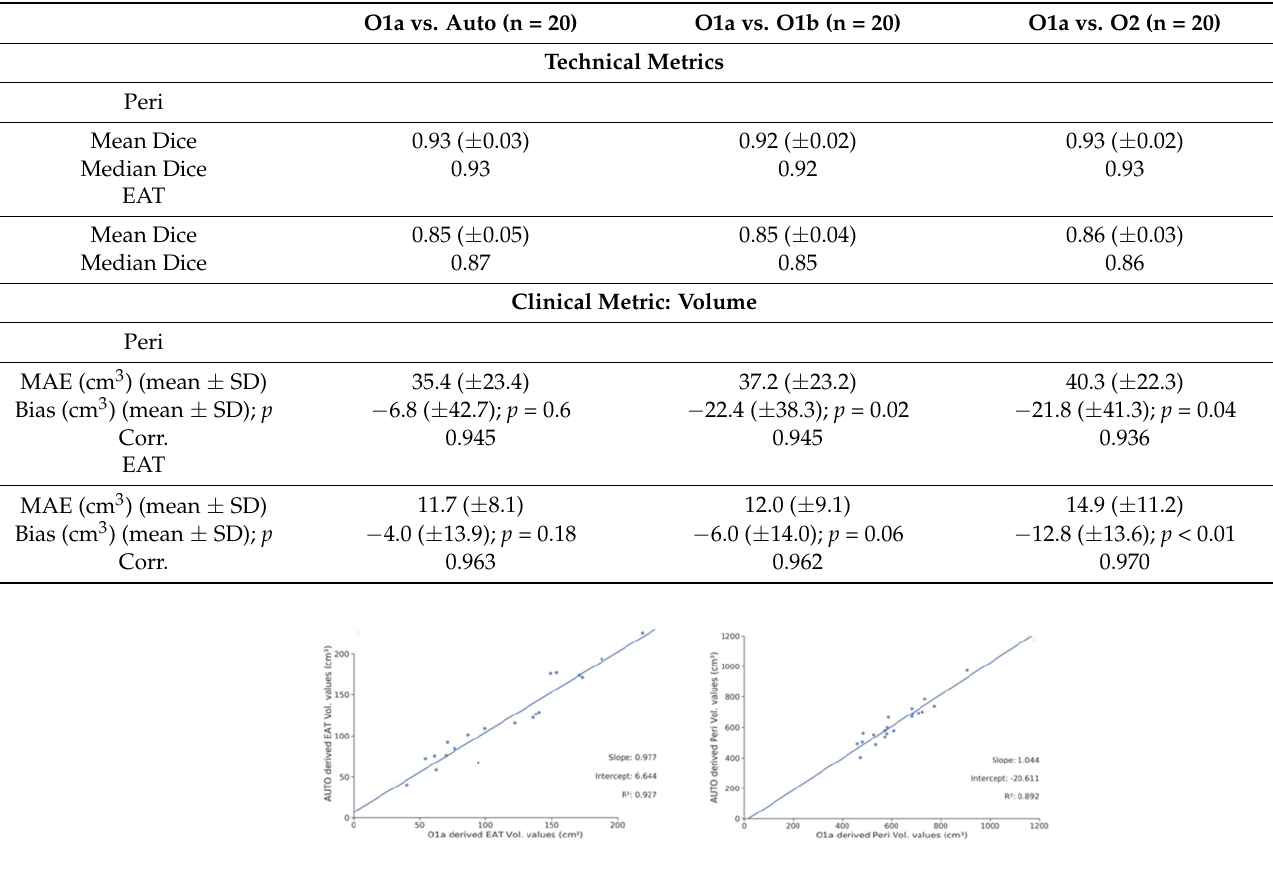
Table 2. Algorithm performance for technical and clinical metrics and comparison of algorithm performance and inter-and intraobserver measure reproducibility’s. SD: standard deviation; Peri: